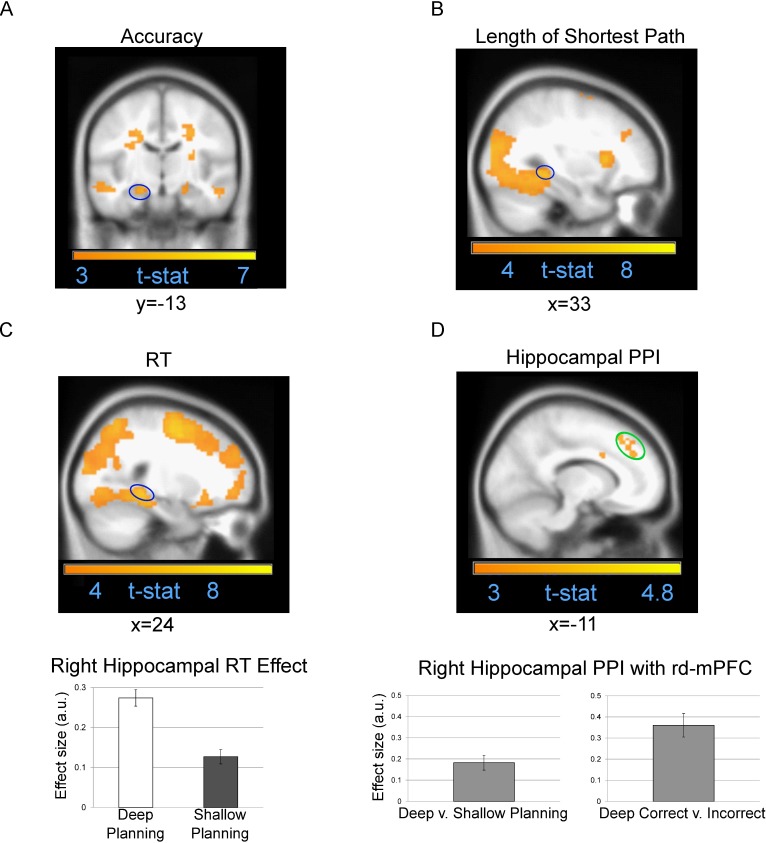
Hippocampal contributions to planning.(A) Coronal image showing higher left hippocampal activity (circled in blue) during planning prior to correct versus incorrect choices. Subthreshold right hippocampal activity that was higher for correct choices is also visible. (B) Sagittal image showing ventral temporal activity extending into right posterior hippocampus (circled in blue) that positively correlated with the distance of the shortest route between the starting and goal location. (C) Top: Sagittal image showing posterior right hippocampal activity during planning that positively correlated with subsequent log RT. Bottom: Effect size for an 8-mm sphere around right posterior hippocampus peak voxel showing that the correlation with log RT is significantly higher (p < 0.05) for deep versus shallow planning trials. All hippocampal peak voxels presented survive correction for multiple comparisons (p < 0.05) across the whole hippocampal volume, but clusters are shown at p < 0.005 uncorrected for visualization purposes. (D) Top: Sagittal image showing medial extent of rd-mPFC (peak voxel same as 3A) that exhibited increased functional connectivity with the right posterior hippocampus in deep versus shallow maze planning trials. Bottom left: Effect size for an 8-mm sphere around rd-mPFC peak voxel (mean ± SEM) showing significantly increased functional connectivity with hippocampus for deep versus shallow planning trials. Bottom right: Hippocampal rd-mPFC functional connectivity (mean ± SEM) was significantly higher during deep planning trials prior to correct versus incorrect choices. See S4 Data for individual effect sizes presented in 5C and 5D.